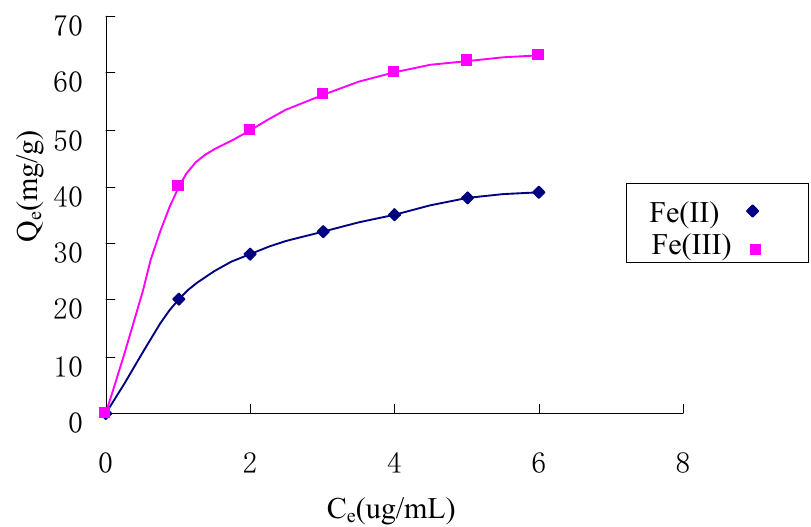
Figure 7. Adsorption isotherms of Fe(II) and Fe(III).